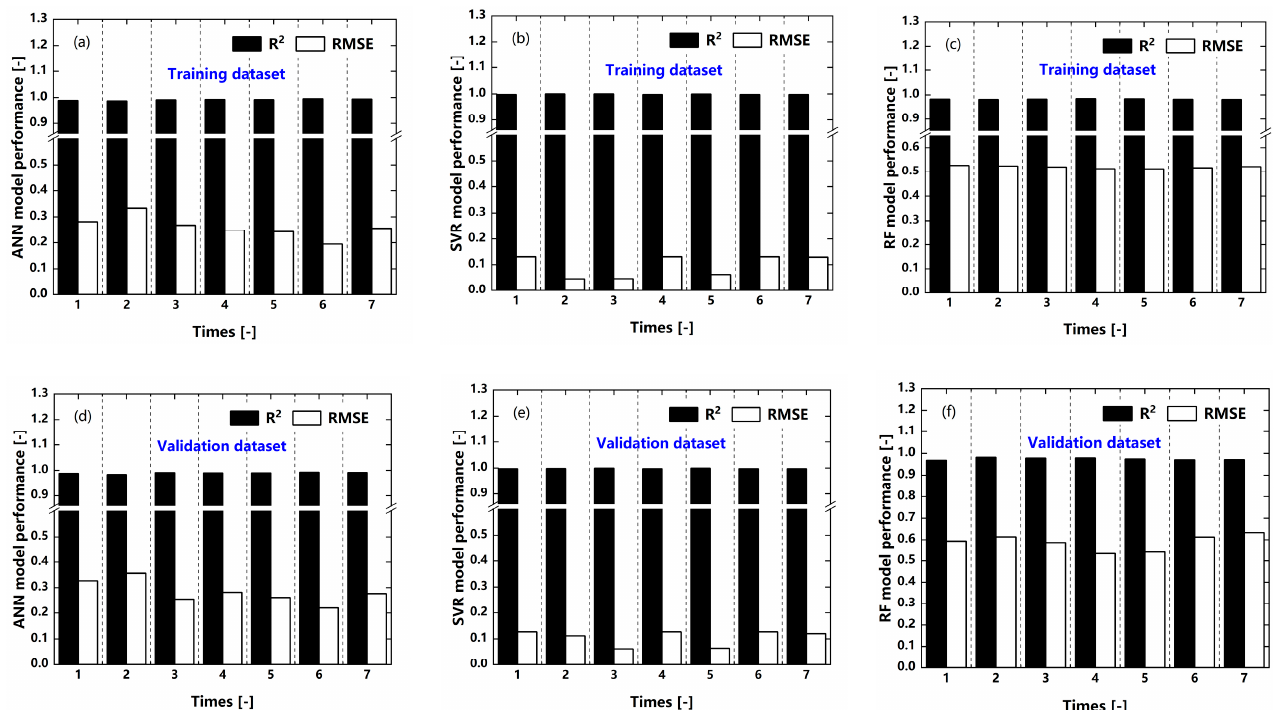
Figure 4. Robustness analysis of three ML models: ( a ) ANN model performance for the training dataset; ( b ) SVR model performance for the training dataset; ( c ) RF model performance for the training dataset; ( d ) ANN model performance for the validation dataset; ( e ) SVR model performance for the validation dataset; ( f ) RF model performance for the validation dataset.